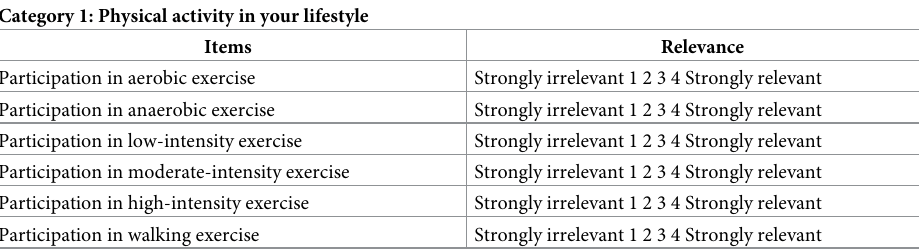
Table 1. Example question asked to assess the relevance of each element in a particular category. Category 1: Physical activity in your